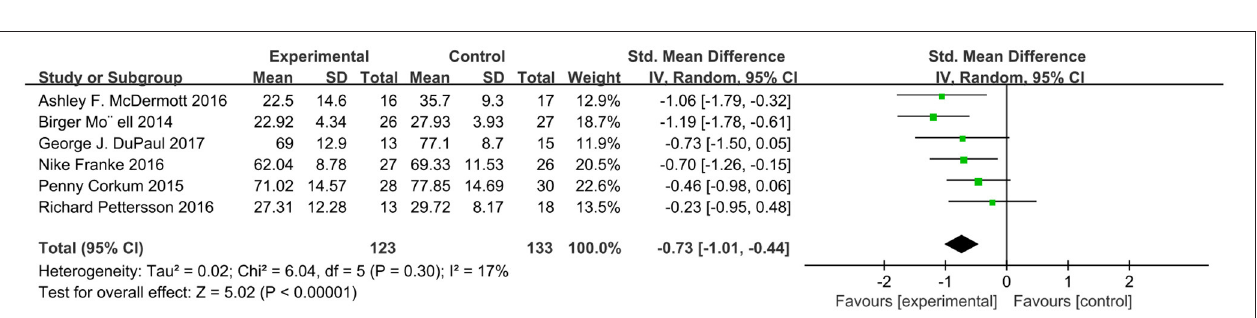
FIGURE 2 | Attention score of online intervention ADHD compared with waiting